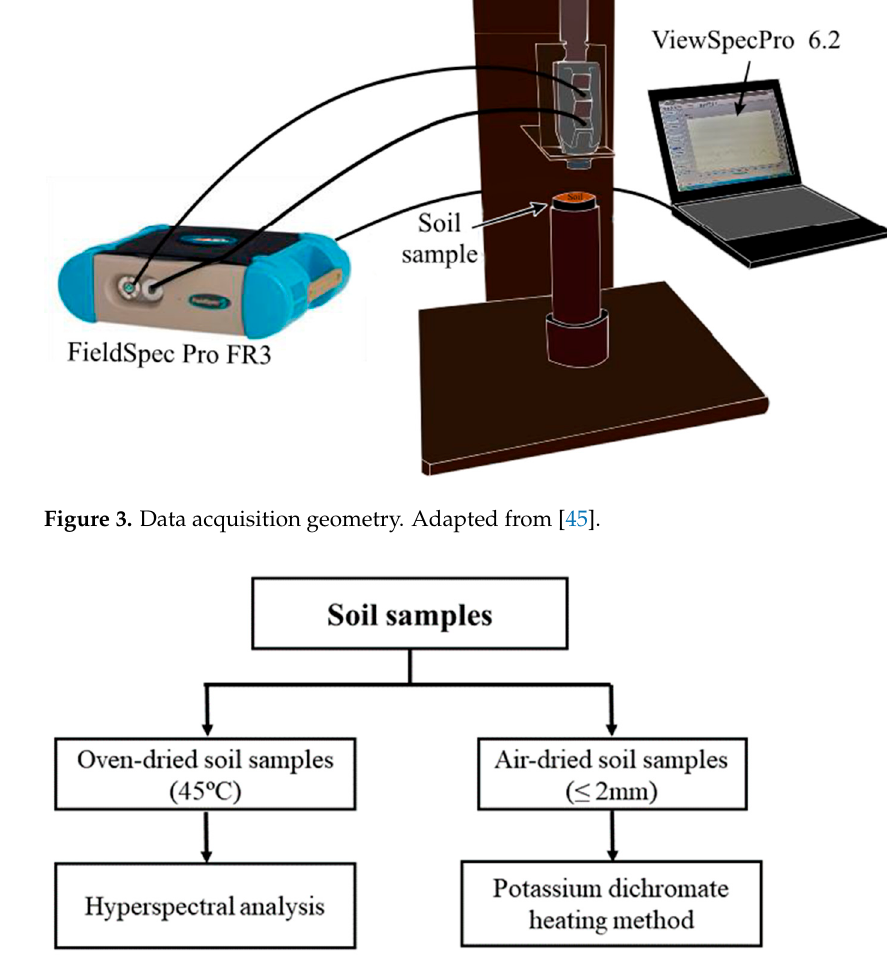
Figure 3. Data acquisition geometry. Adapted from [45].